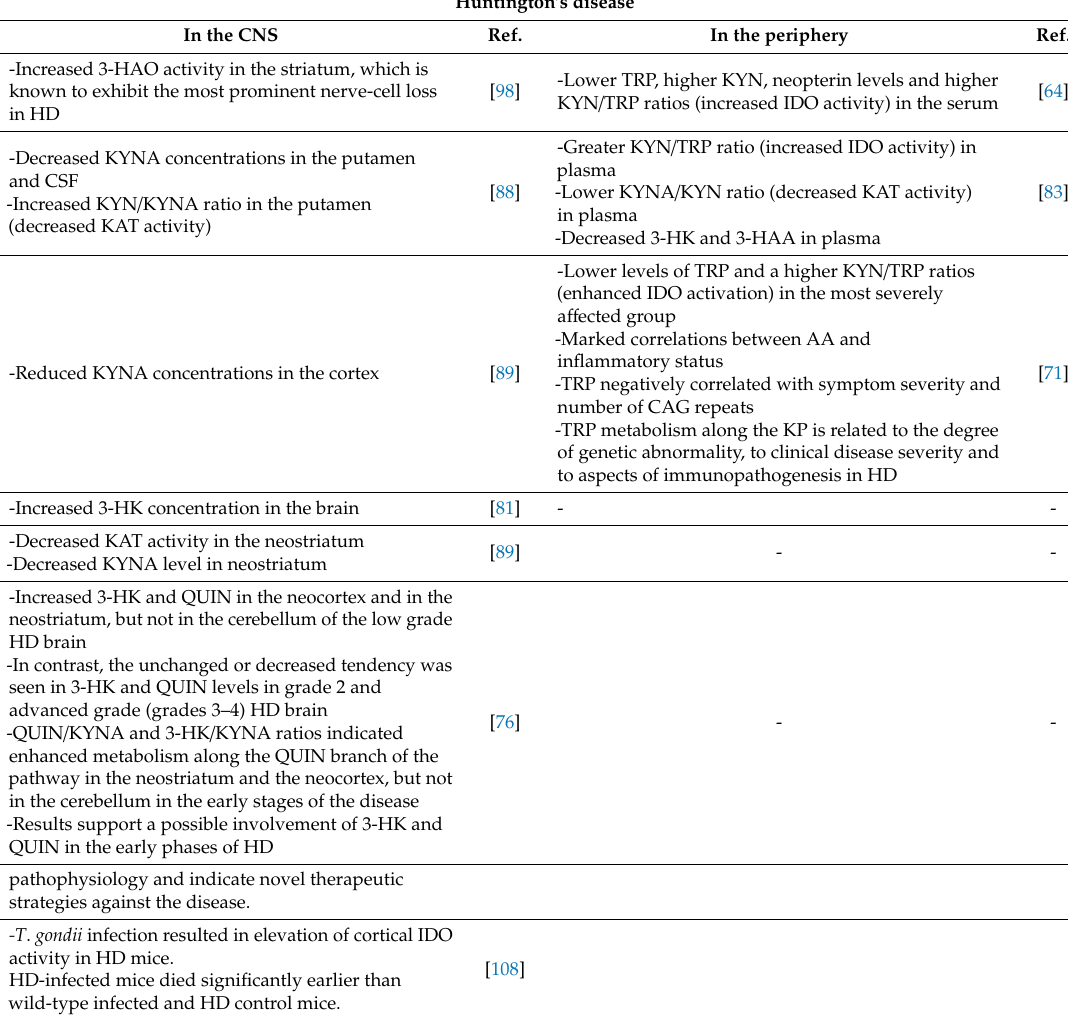
Table A4. Di ff erences of kynurenine pathways in the CNS and the periphery in Huntington’s disease. Huntington’s disease